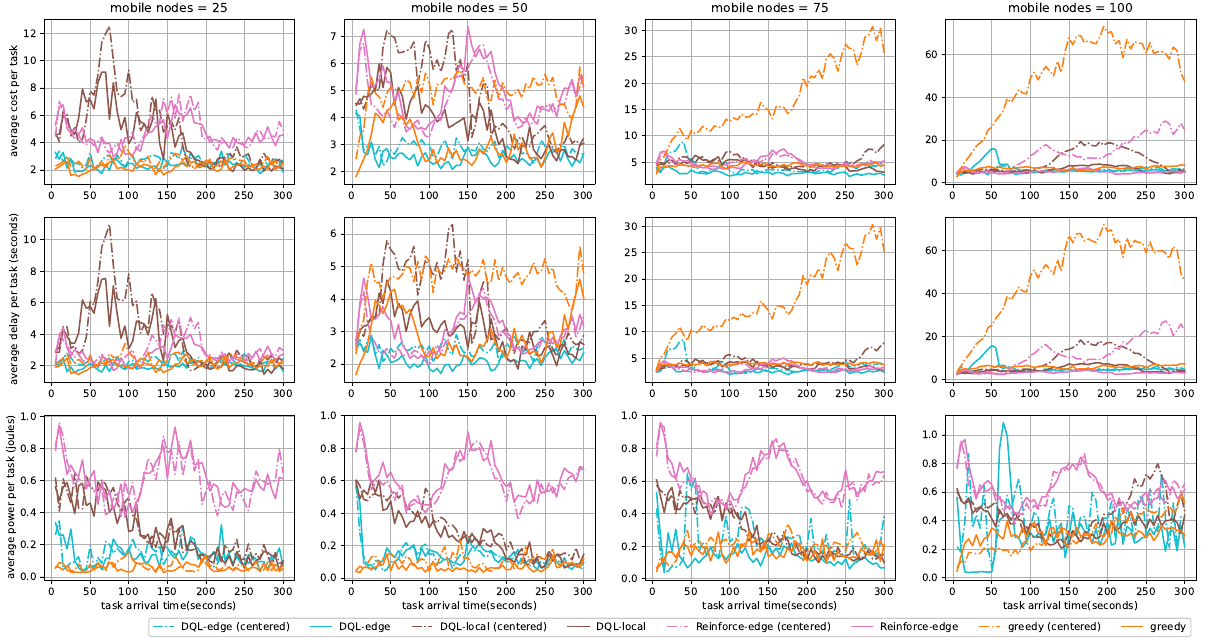
Figure 3. Comparing the cost, delay, and power consumption of the DQL-edge, DQL-local, reinforce- edge, and greedy task offloading models for the duration of the simulation. The simulation was run for both centered and uniform positioning of mobile devices and when the number of mobile devices was 25, 50, 75, and 100.